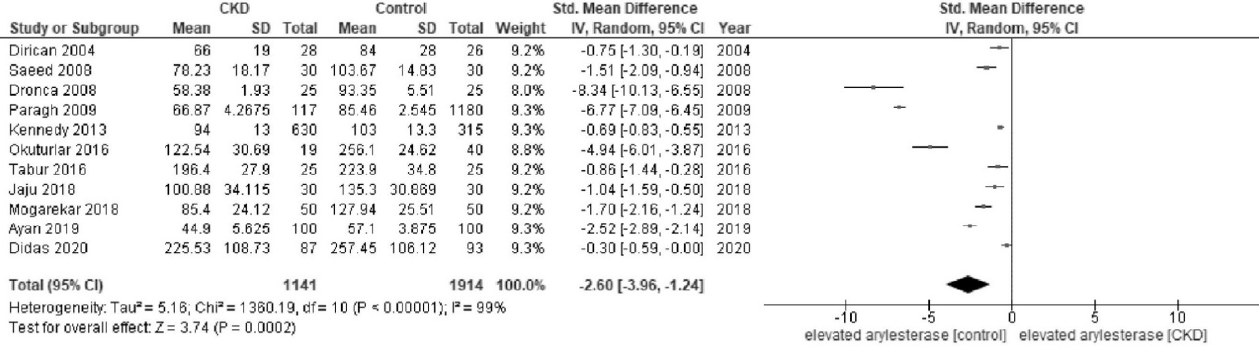
Figure 3. Forest plot of arylesterase activity in all studies [28,30,32,34,39,41–43,45–47].